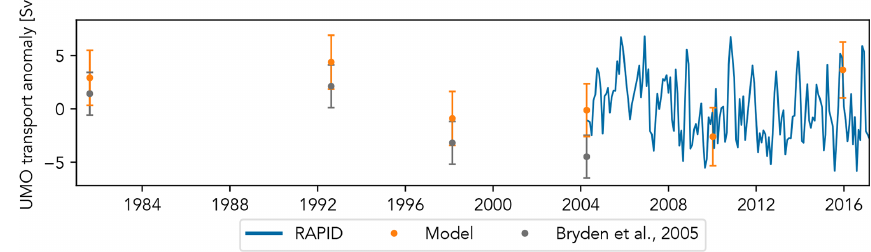
Figure 7. UMO transport anomaly estimated by the empirical model using density anomalies from six transatlantic hydrographic sections, compared to estimates from Bryden et al. (2005) and RAPID. The uncertainties shown for the model-derived values are the model’s prediction intervals; the Bryden et al. (2005) uncertainty is